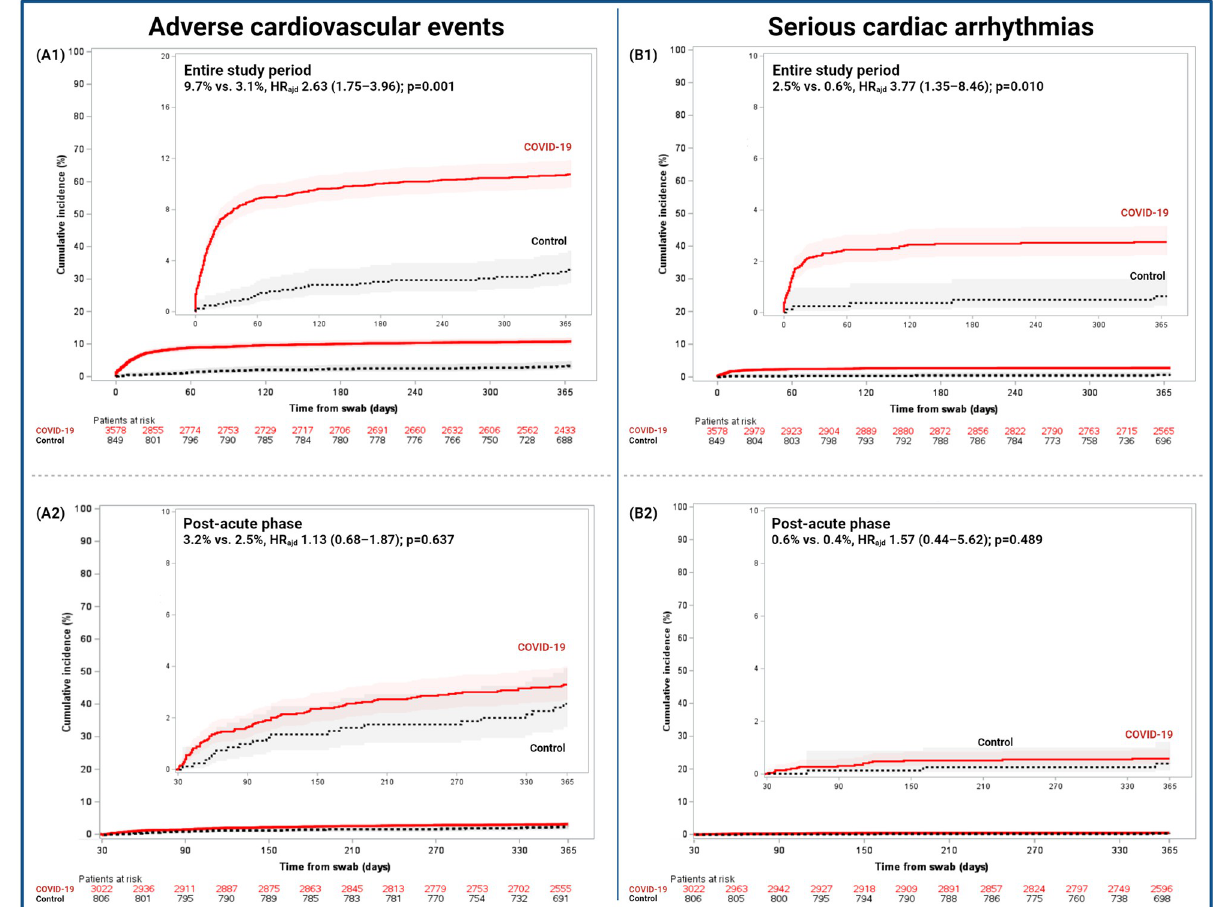
Fig 2. Cumulative incidence of adverse cardiovascular events and serious cardiac arrythmias in the COVID-19 and control cohorts. Cumulative 1-year incidences are shown with Kaplan-Meier event rates with 95% CI. (A1 and B1) Entire study comprised from 0–365 days and (A2 and B2) post- acute phase from 31–365 days. Adj HR, adjusted hazard ratio; 95%CI, 95% confidence interval.